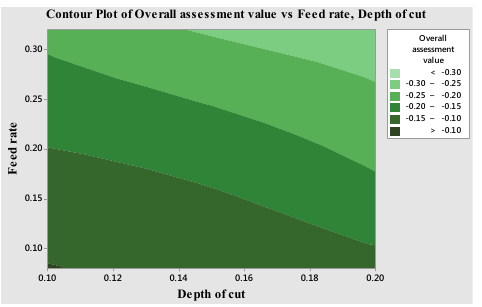
Fig. 9. Contour Plot of Overall assessment value vs. Feed rate and Depth of cut